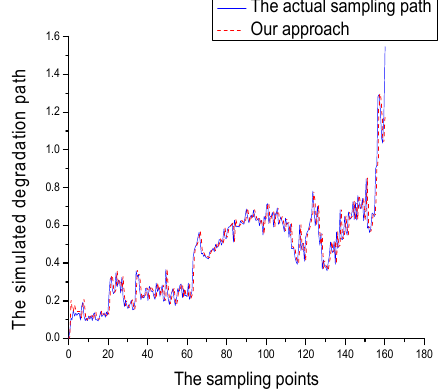
Figure 5. Our approach simulates the degradation path.